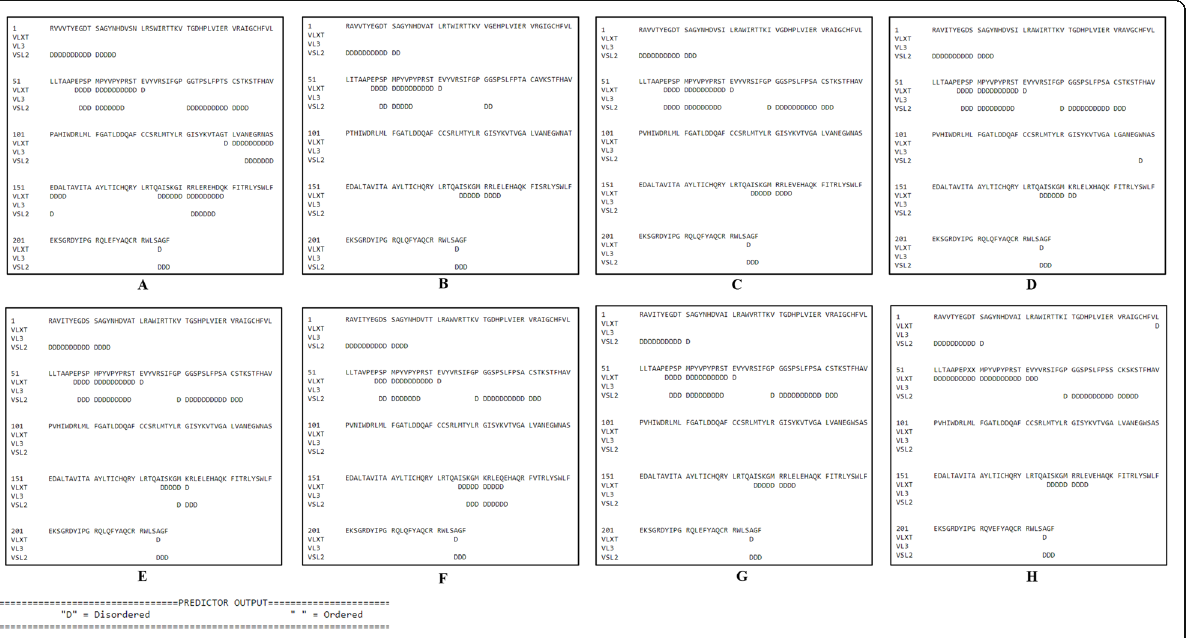
Fig. 4 Prediction of disordered residues in HEV YDR. A JF443720 (GT 1); B M74506 (GT 2); C AB222182 (GT 3); D GU119961 (GT 4); E AB573435 (GT 5); F AB602441 (GT 6); KJ496143 (GT 7); and H KX387865 (GT 8). The prediction of disordered residues was carried out using three members of the family PONDR (Prediction of Natural Disordered Regions), i.e., VLXT, VL3, and VSL2. A threshold value of 0.5 was set to distinguish between ordered and disordered regions along the genome (dashed line). Regions above the threshold are predicted to be disordered. The predicted disordered residues are shown with the alphabet “ D